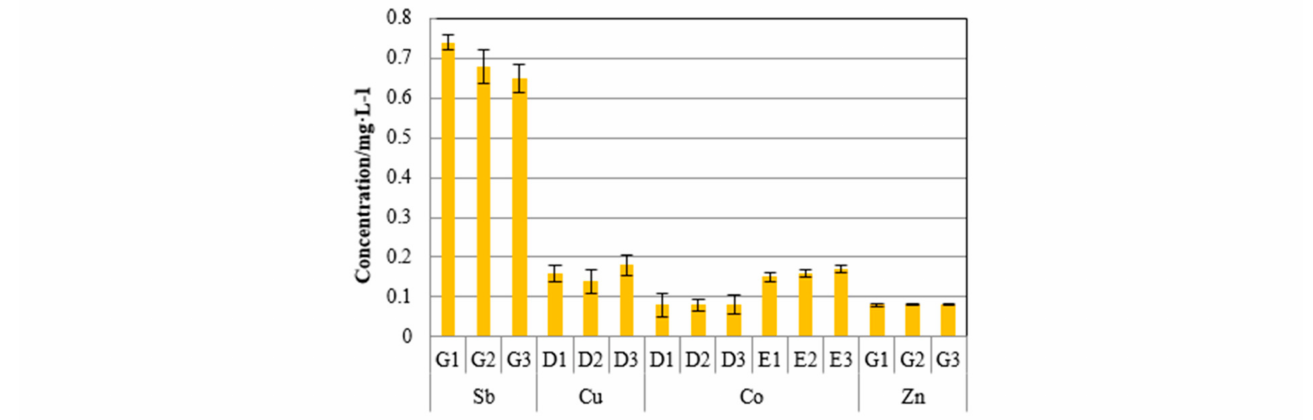
Figure 4. Heavy metal leaching concentration of spent catalysts.